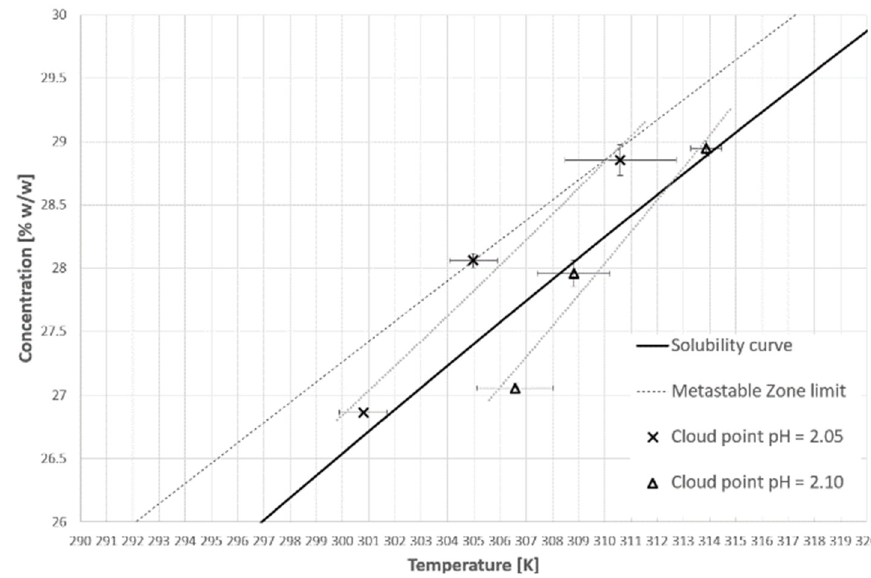
Figure 5. Cloud point temperatures for the first cooling cycle.